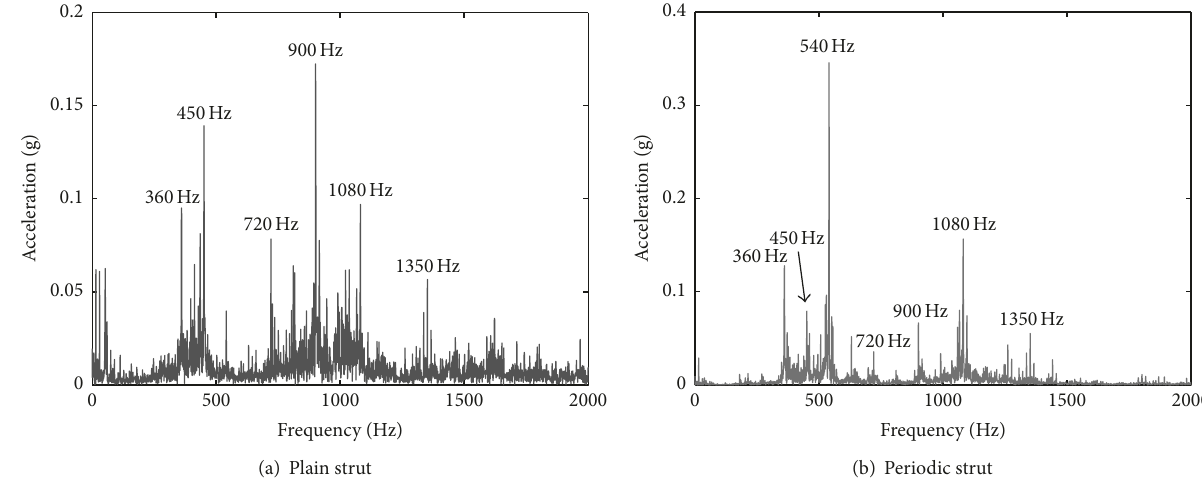
Figure 11: Frequency response on the gearbox attachment points.